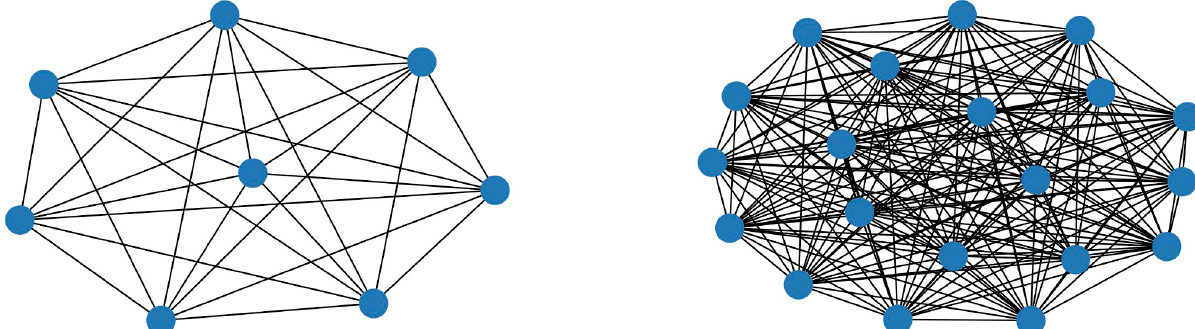
Fig 3. Graphs of QUBOS. A: Butane ( C 4 H 10 ), B: Heptane ( C 7 H 16 ).